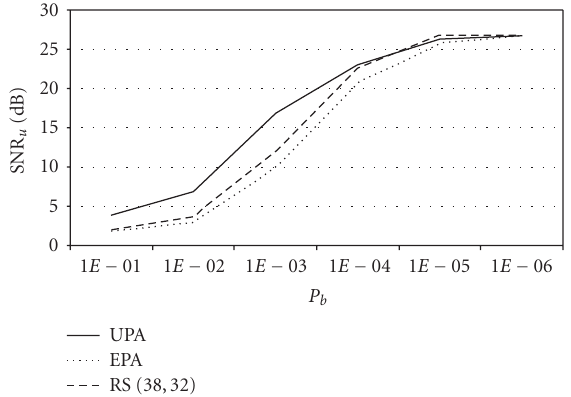
Figure 9: Achieved quality for the parameter u 2 ( τ ).